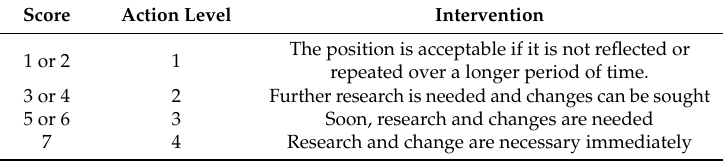
Table 1. Interpretation of results for the Rapid Upper Limb Assessment (RULA) module.